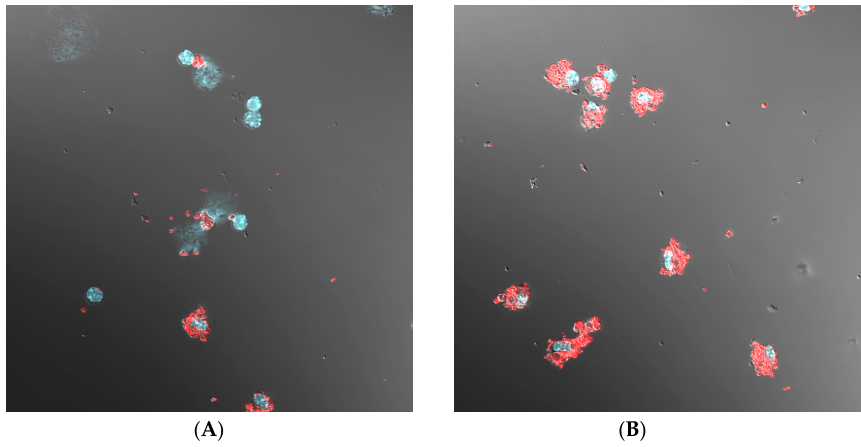
Figure 3. Confocal microscopy images of 4 ′ ,6-diamidino-2-phenylindole (DAPI)-stained macrophages, derived from the peritoneal cavity of the mice, with ( A ) PLA microparticles modified by bovine serum albumin (BSA)–Cy3; ( B ): PLA microparticles modified by camel immunoglobulin G (IgG)–Cy3.